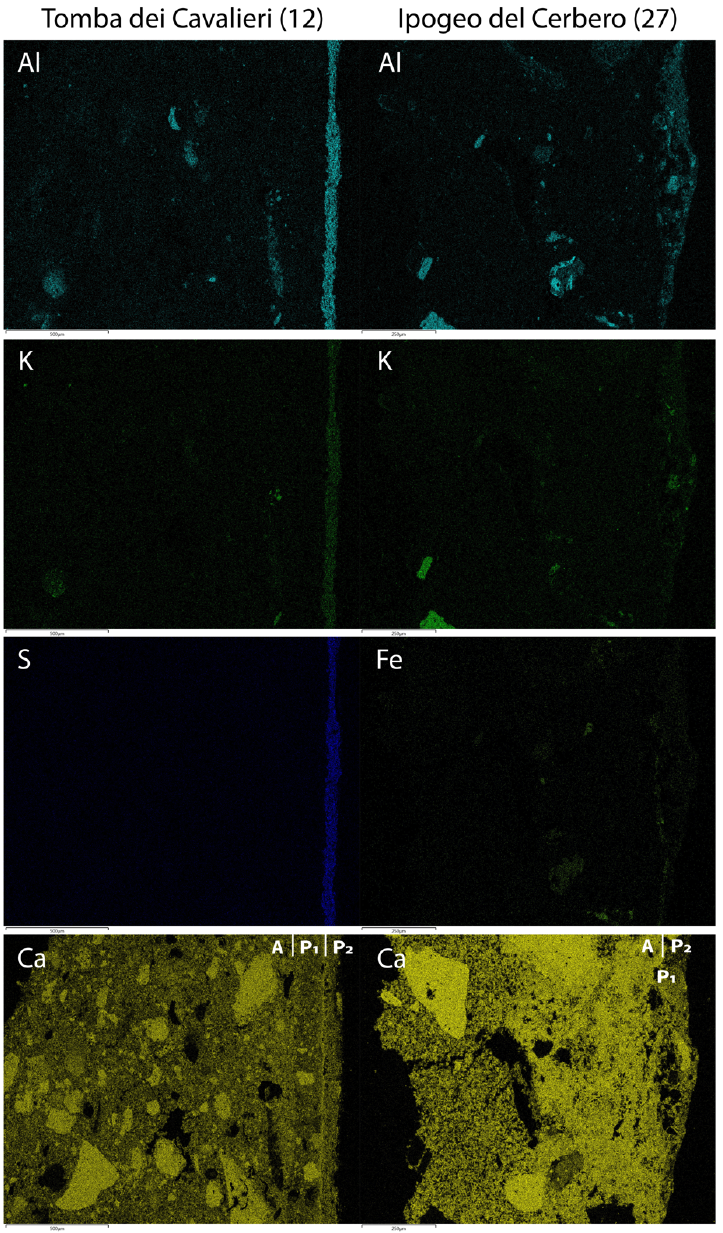
Figure 3. X-ray chemical maps showing and relative stratigraphy of samples 12 and 27. See Table 1 for details.